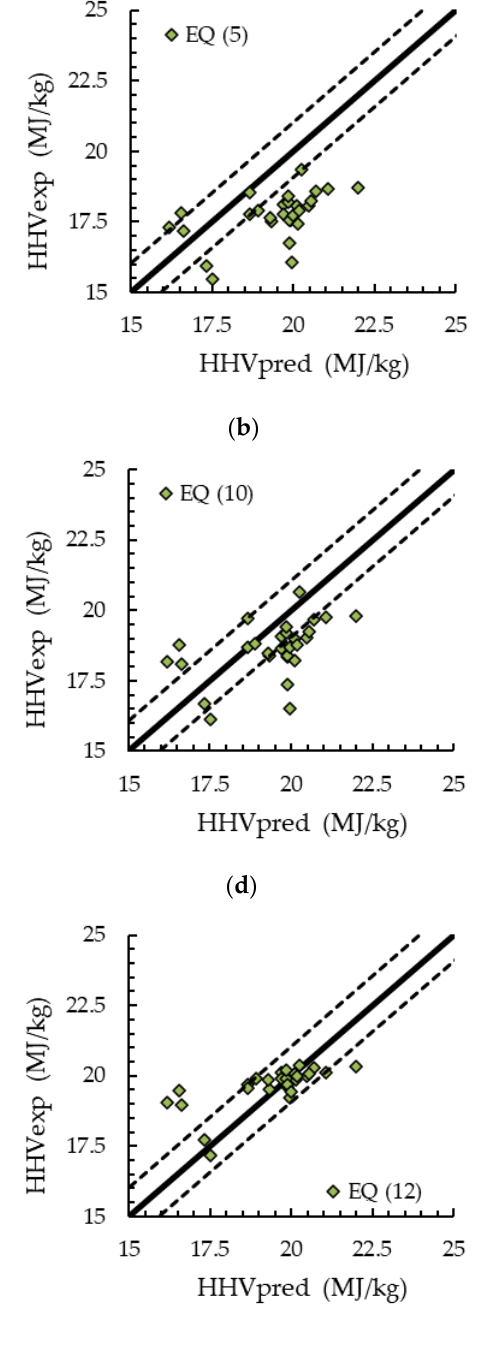
( b ) Figure 9. Graphs with the main error analyses for HHV predictions from equations based on the proximate analysis: ( a ) mean absolute error (MAE) and square root mean error (SRME); ( b ) mean absolute percentage error (MAPE). * ID: equation identification. The performance of the equations from the literature in predicting the HHVs of Am-